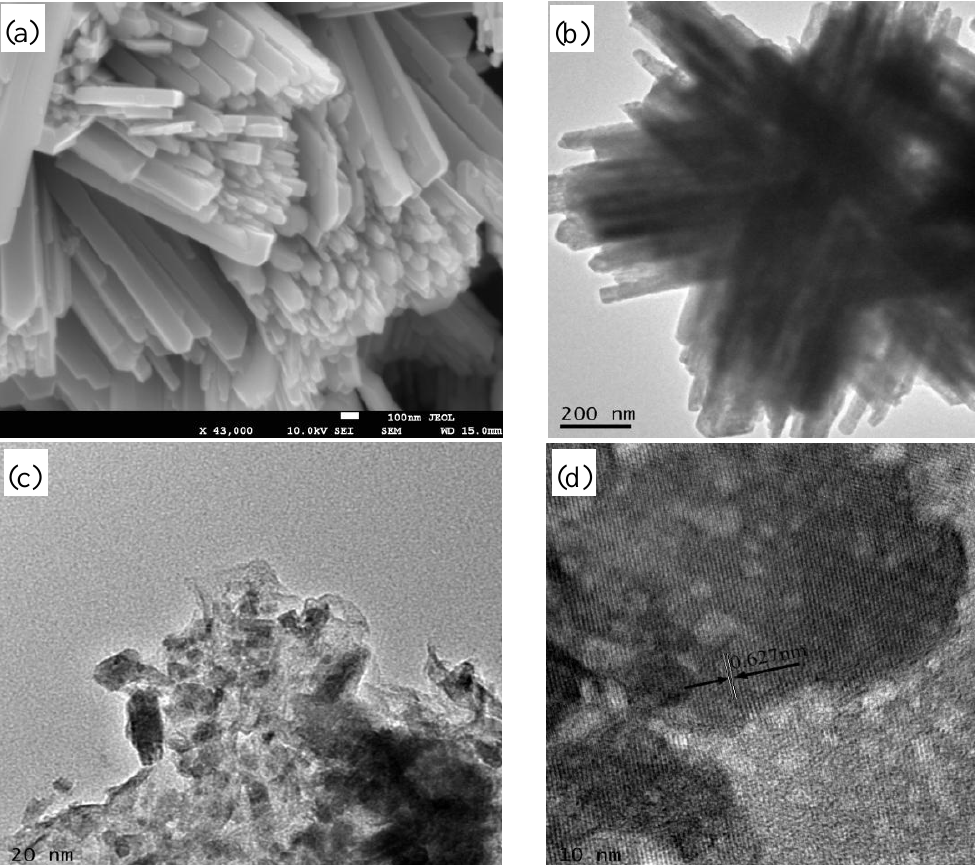
Figure 6. Morphologies of samples: ( a ) SEM images of WO